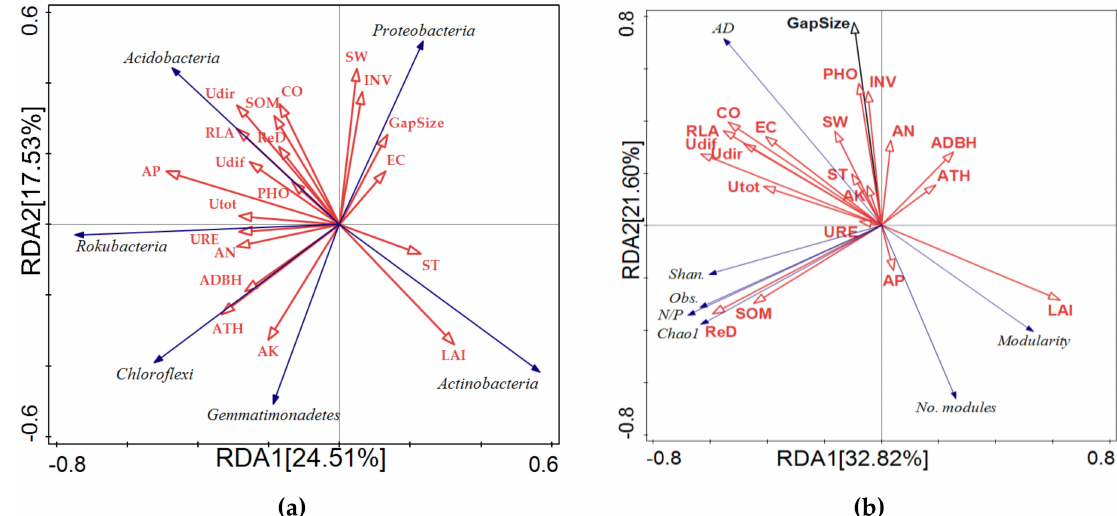
Figure 5. ( a ) Constrained ordination analysis of bacterial community composition with gap-related microenvironmental factors; ( b ) constrained ordination analysis of bacterial community diversity, and network structure with gap-related microenvironmental factors. Notes: ( a ) the relationships between gap-related microenvironmental factors (red arrows) and dominant phyla (blue arrows); ( b ) the relationships between gap-related microenvironmental factors (red arrows) and alpha di- versity indices and network topological characteristics indices (blue arrows). Note: AD, average degree; N/P cohesion, negative and positive connection proportions; No. modules, number of modules; Shan., Shannon index; Obs., number of observed species; ReD, regeneration density; ADBH, average diameter at breast height of regeneration individuals; ATH, average height of regeneration